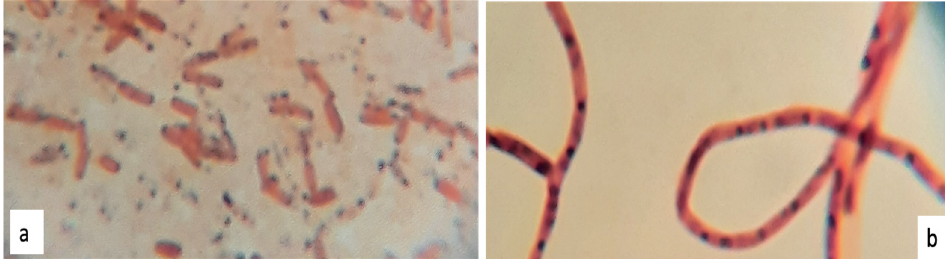
Figure 3. Sudan black B staining for PHB smears identification on petri dishes; presence of black smears for the two positive PHB producers: 1B ( a ) and 2D1 ( b ).